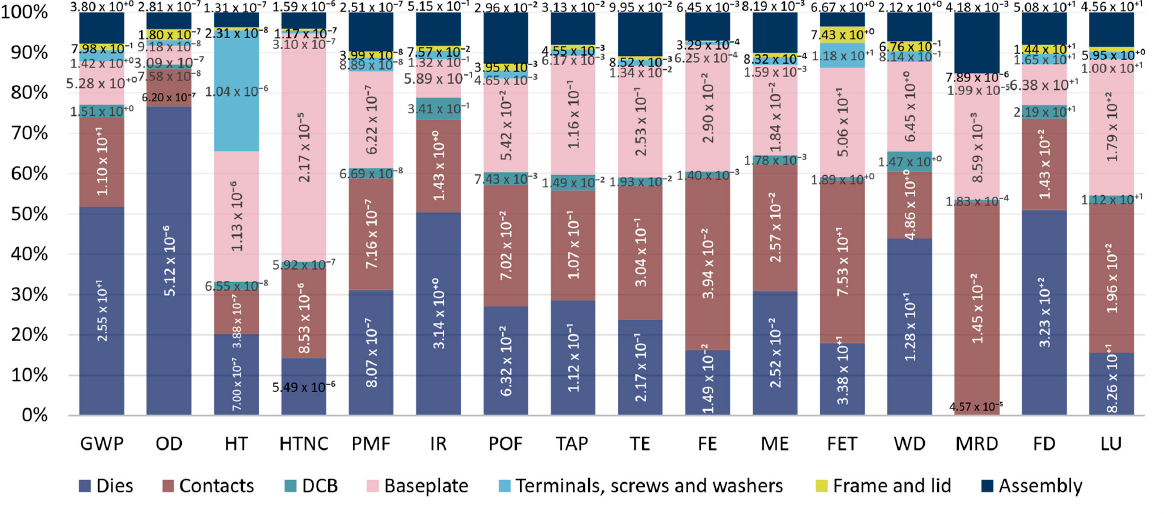
Figure 8. Standardized environmental impacts of contact ( a ) and baseplate ( b ) processes for the power module (150 kW), given the European Commission recommendations for choosing impact categories [27]. Abbreviations are presented in Table 1.